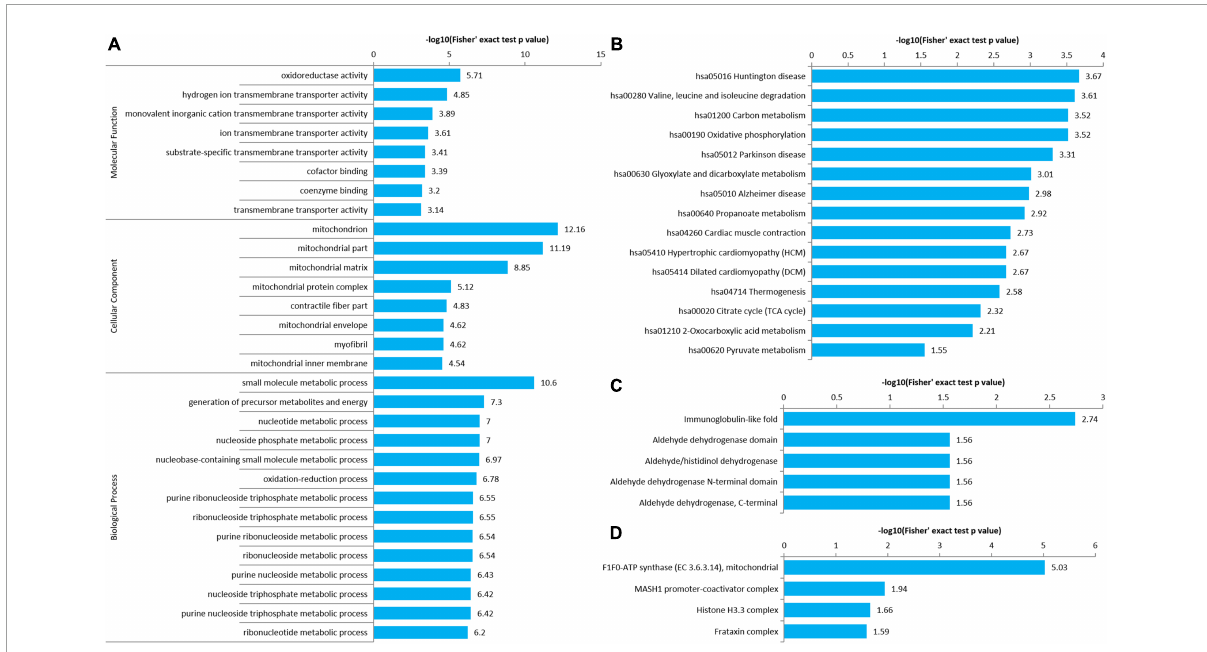
FIGURE4 Enrichment analysis of GO, KEGG pathway, protein domain, and protein complex of the AF/SR differentially expressed acetylated proteome in LAA tissues. (A) GO (molecular function, cellular component, and biological process). (B) KEGG pathway. (C) Protein domain. (D) Protein complex. GO, gene ontology; KEGG, Kyoto Encyclopedia of Genes and Genomes; AF, atrial fibrillation; SR, sinus rhythm; LAA, left atrial